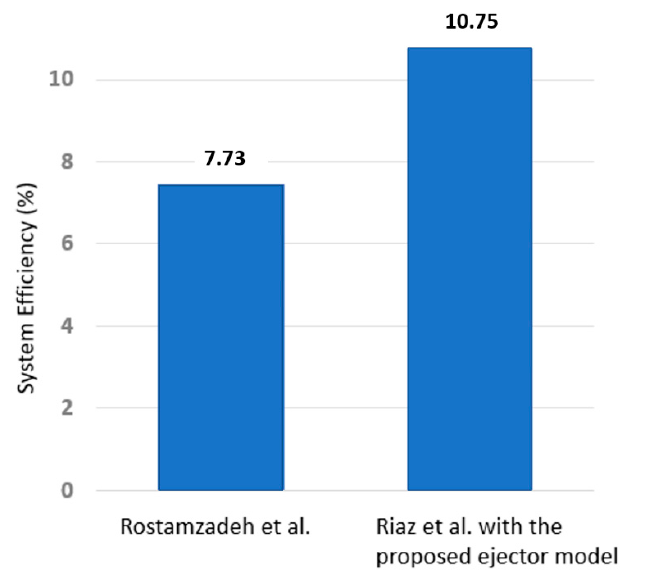
Figure 15. Figure 15. Optimization of a novel CCP using the proposed ejector model and its performance comparison .